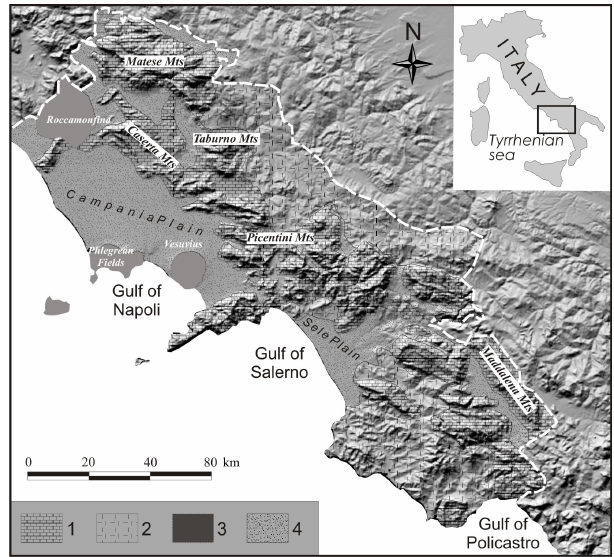
Figure 1. Location and geological setting of the study area. Key: (1) Mesozoic carbonate massifs; (2) Cenozoic hilly terrigenous ar- eas; (3) Quaternary volcanic areas; (4) Quaternary intermountain catchments and coastal plains. The broken line indicates the bound- aries of